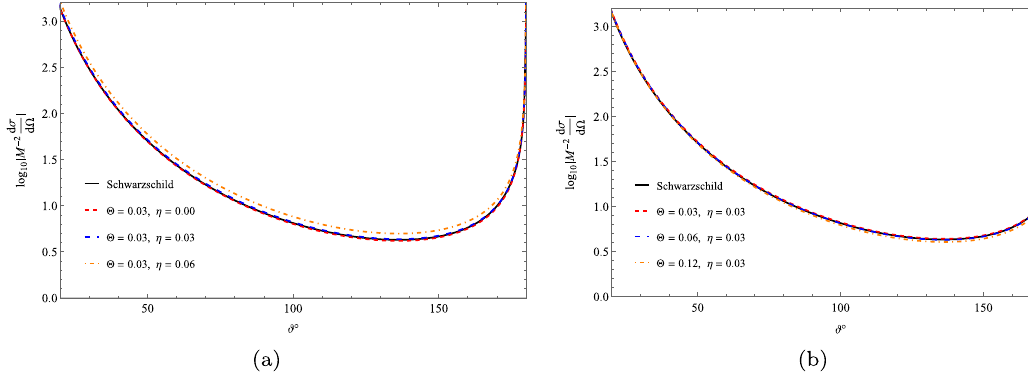
Fig. 14 Classical scattering differential cross section versus ϑ o (angle)